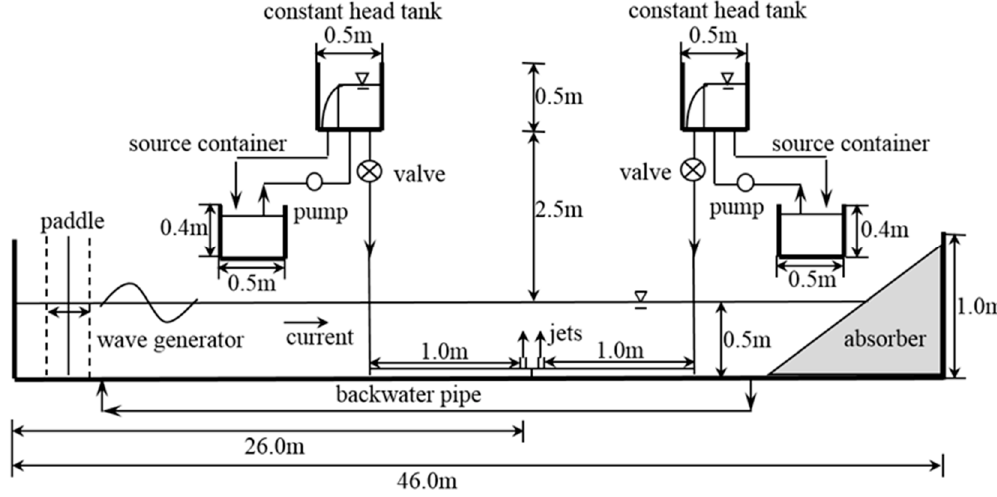
Figure 1. Sketch of the experimental setup.